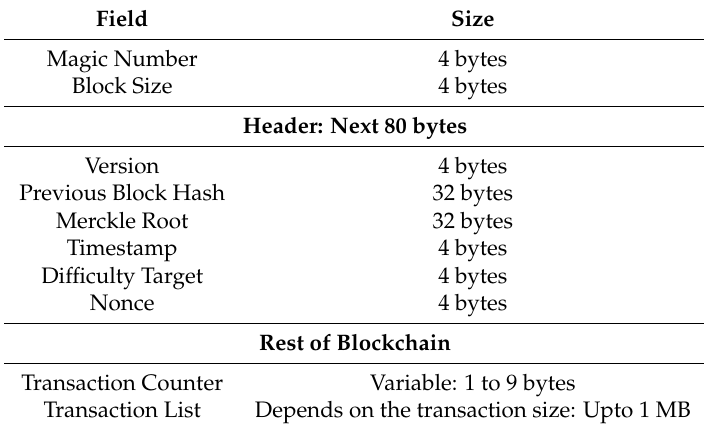
Table 1. Structure of the